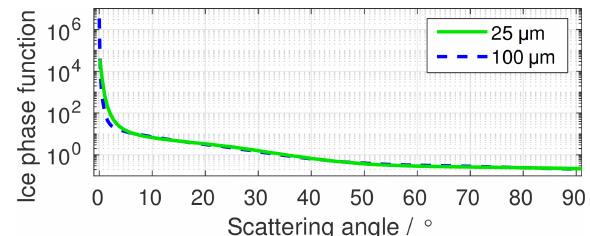
Figure 1. Ice phase functions used in this study, originally designed for use in cloud retrievals from MODIS. Phase functions are shown for the forward scattering direction at wavelength 465nm, for two ice particle effective diameters (see legend).